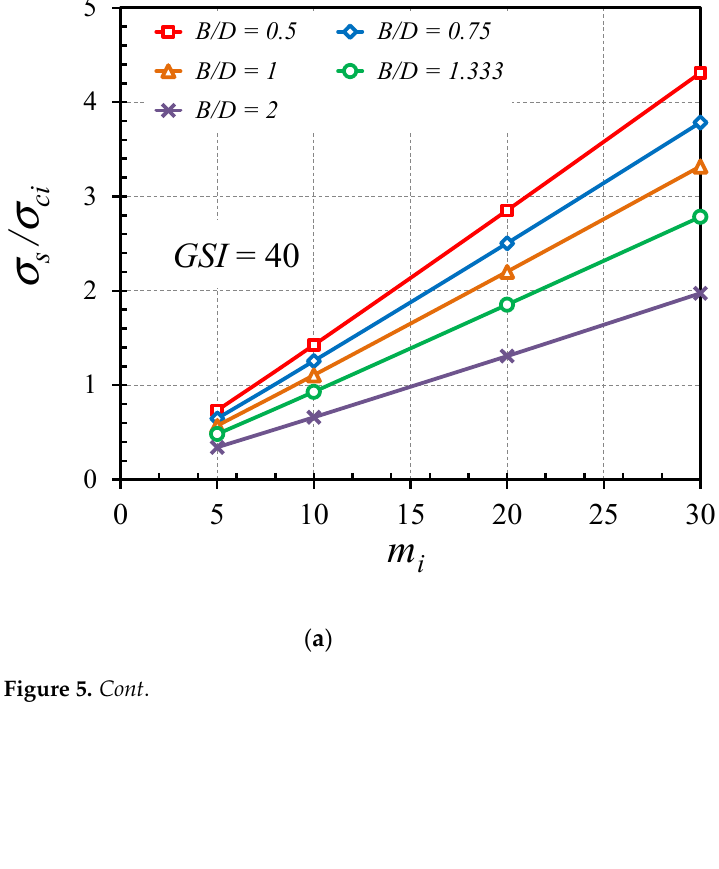
( b ) Figure 5. Impact of m i on σ s / σ ci of horseshoe tunnels with C / D = 3 and σ ci / γ D = 1000: ( a ) GSI = 40 and ( b ) GSI = 100.